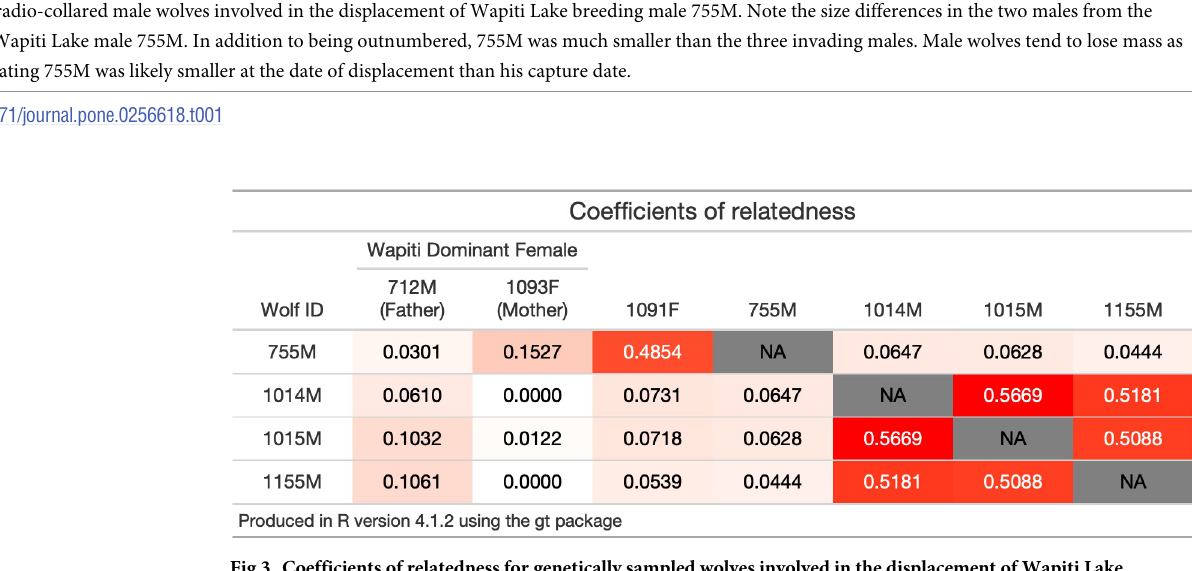
Fig 3. Coefficients of relatedness for genetically sampled wolves involved in the displacement of Wapiti Lake dominant male 755M in Yellowstone National Park. Cell colors range from white (relatedness value of 0, indicating a pair is completely unrelated) to red (highest relatedness value of 0.5669, belonging to the sibling pair of 1014M and 1015M). Relatedness of approximately 0.5 is indicative of either full sibling or parent/offspring relationships. The uncollared black male from the Mollie’s pack was later captured and assigned the number 1155M. The gray female yearling was also later captured and assigned the number 1091F. The Yellowstone Wolf Project has not genetically sampled the Wapiti Lake dominant breeding female, so her parents’ (712M and 1093F) coefficients of relatedness are included here. See vonHoldt et al. 2020 for genotyping methods used to estimate relatedness